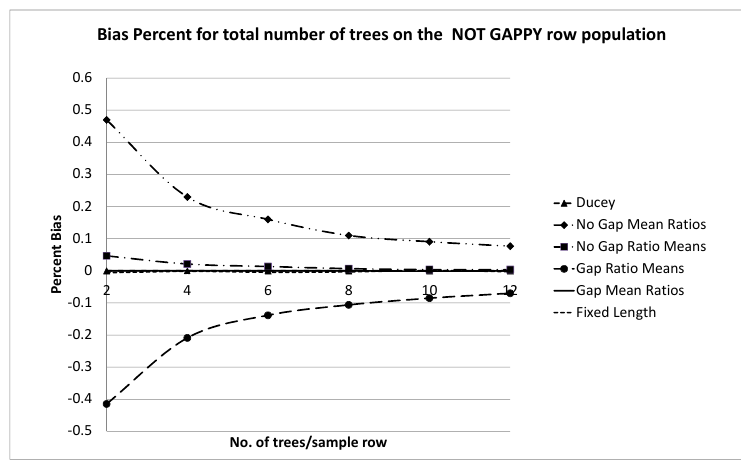
Figure 6. Bias percentages on the NOT GAPPY row population for the total number of trees estimated by Ducey’s estimator, ¯ˆ Y D shown in Equation (7); the “No Gap Mean Ratios” estimator, ˆ Y NG − MR , shown in Equation (17); the “Gap Mean Ratios” estimator, ˆ Y G − MR , shown in Equation (12); the “No Gap Ratio Means” estimator, ˆ Y NG − RM , shown in Equation (11); the “Gap Ratio Means” estimator, ˆ Y G − RM , shown in Equation (10); and fixed length row sampling for 10 random sample locations and numbers of trees per sample, ranging from 2 to